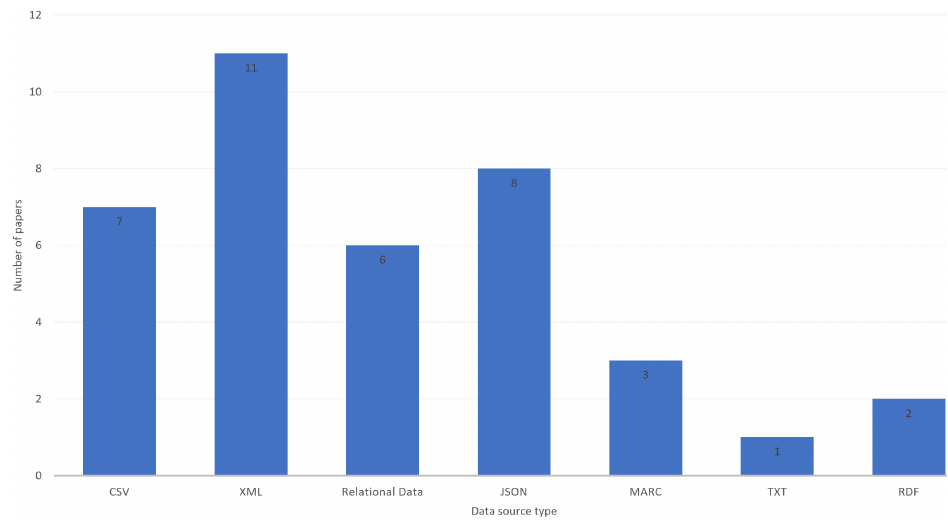
Figure 3. Data source types